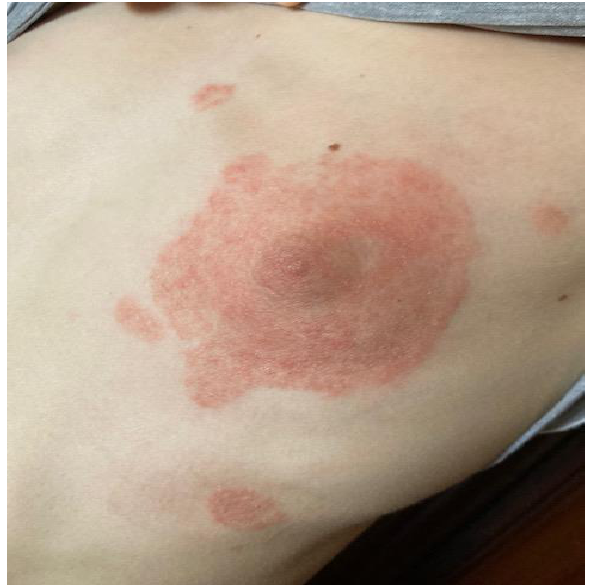
Figure 1. Trichophyton mentagrophytes caused dermatophytosis in an 11-year-old girl.